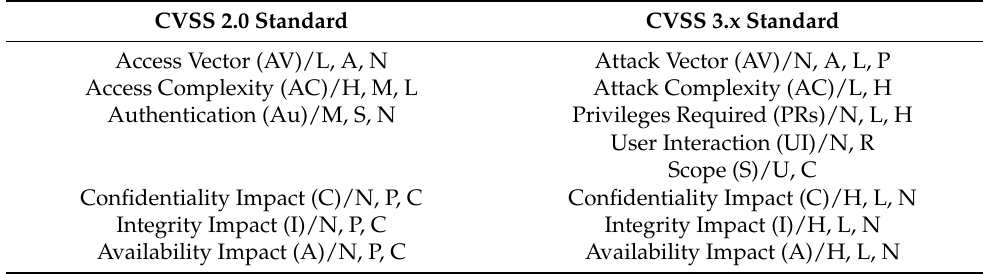
Table 1. Differences in the construction of the CVSS 2.0 and CVSS 3.x base vectors. CVSS 2.0